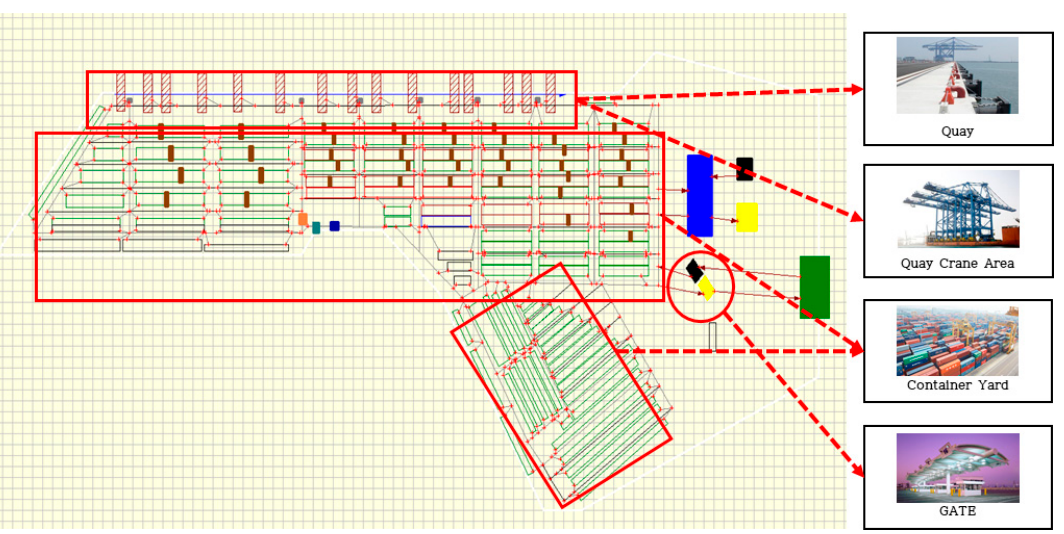
Figure 3. Simulation modeling of virtualized port-container terminal.